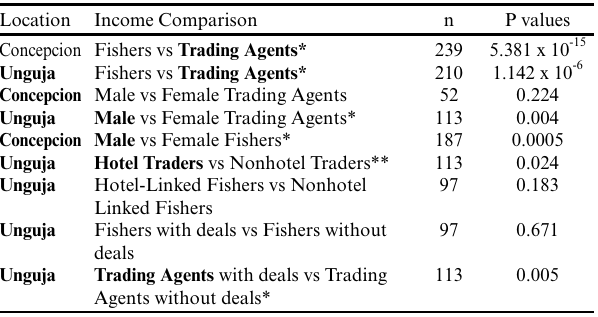
Table 2 . Nonparametric Wilcoxon test results for the different income levels among various nodes or node groups. * Indicates p-value under 0.01 and ** under 0.05. The bold font indicates the group with the higher income and the regular font those with the lower